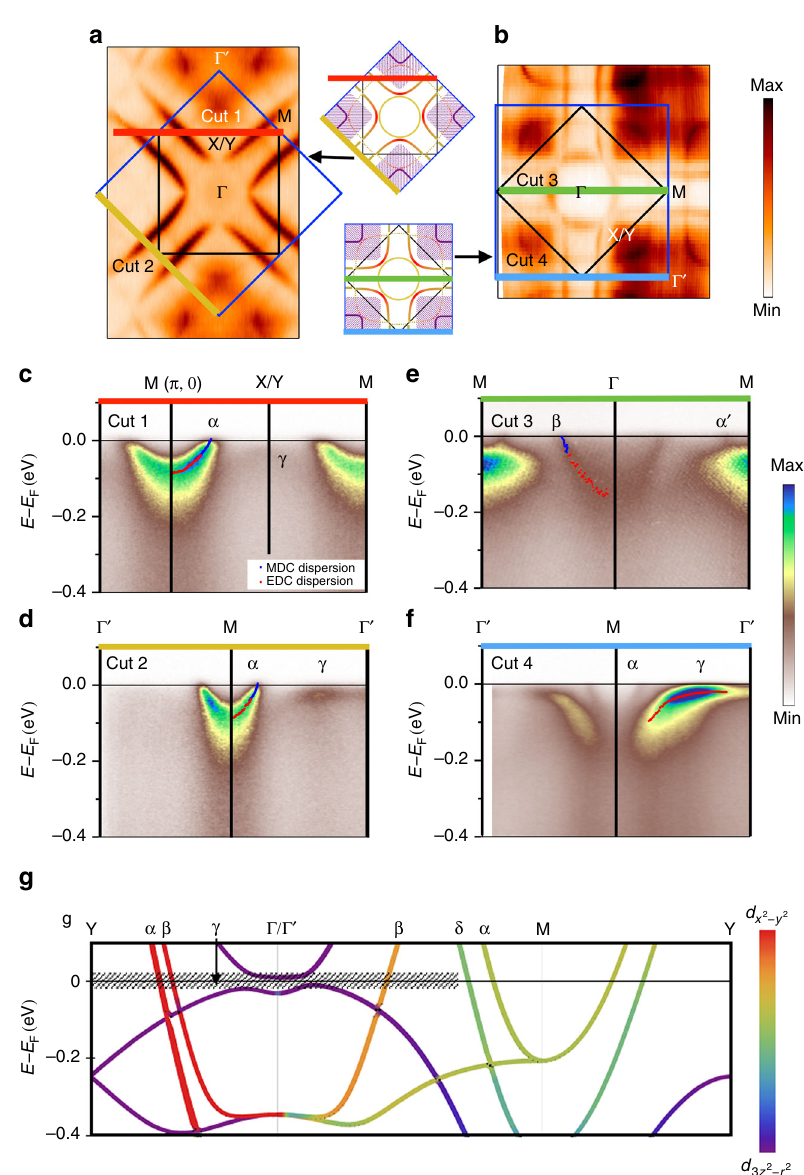
Fig. 2 Fermi surface maps and high symmetry cuts of La 4 Ni 3 O 10 measured at low temperature ( T = 30 K). a , b Fermi surface maps of La 4 Ni 3 O 10 taken with different experimental geometries, where map a emphasizes the cuprate-like hole pocket ( α band), while map b shows the comprehensive structure. The blue and black boxes are the unfolded and folded Brillouin zones, respectively. c – f ARPES spectra of the high symmetry cuts. Each high symmetry cut position is indicated as the colored line in a , b . Cut 4 is taken along Γ -M in the second Brillouin zone to avoid the weak matrix element in the fi rst Brillouin zone. The dots in c – f depict the MDCs ( blue ) and EDCs ( red ) peak position, which indicate the band dispersion. g Band structure from DFT calculation under the folded Brillouin zone. The weightings of d 3 z 2 (cid:1) r 2 and d x 2 (cid:1) y 2 orbital character are shown with different color scales. The hatched area indicates the blurry area from the γ band spectral weight in the Fermi Fig. 1 show the Fermi surface of La 4 Ni 3 O 10 taken at 30 K and the back-folded feature resembles the shadow band observed in the corresponding schematic drawing. The original Brillouin zone cuprate Fermi surface 15 – 18 . In Fig. 1f, we sketch the reconstructed that corresponds to the Ni-O plaquette is marked as the blue box , Fermi surface with all the back-folded bands shown as thin dotted while the black box corresponds to the folded Brillouin zone of curves . However, the measurement only reveals the β pocket La 4 Ni 3 O 10 . Different parts of the Fermi surface are highlighted ( yellow circle ) at the original Brillouin zone center while the γ with different colors and marked as α , α ′ , β and γ in Fig. 1b. In pocket ( purple ) is only present at the original Brillouin zone resemblance to the cuprate ((Bi,Pb) 2 Sr 2 CaCu 2 O 8+ δ ) Fermi surface corner. This absence of a strong back-folded band feature from antibonding band shown in Fig. 1c, d, La 4 Ni 3 O 10 also displays a the broken translation symmetry of the crystal has been observed – 21 large hole pocket centered at the corner of the original Brillouin . in many other materials and investigated in previous studies 19 zone ( α band). Due to the doubling of the unit cell, this cuprate- When the folding potential from the broken translation sym- like hole pocket ( α band) is ( π , π ) back-folded, with the back- metry is weak, the spectral intensity of the back-folded bands is folded bands drawn as dashed curves ( α ′ band) in Fig. 1b. This also expected to be extremely weak, and sometimes further